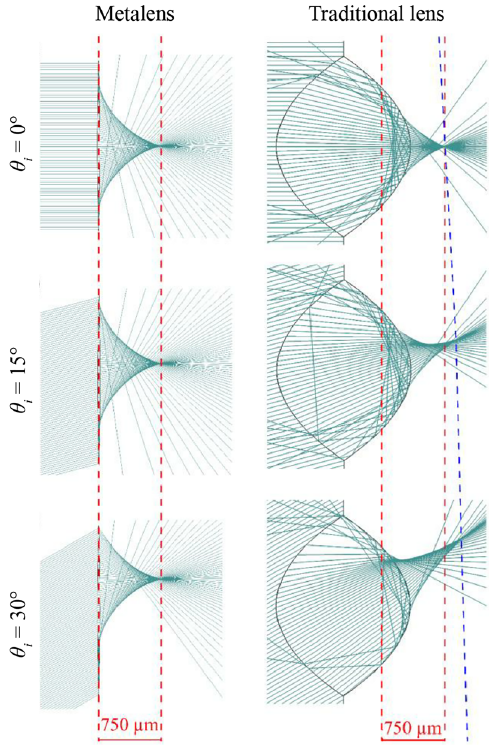
Figure 4: Comparison between the wide-angle metalens (first col- umn) and an equivalent bulk quadratic lens (second column) at different